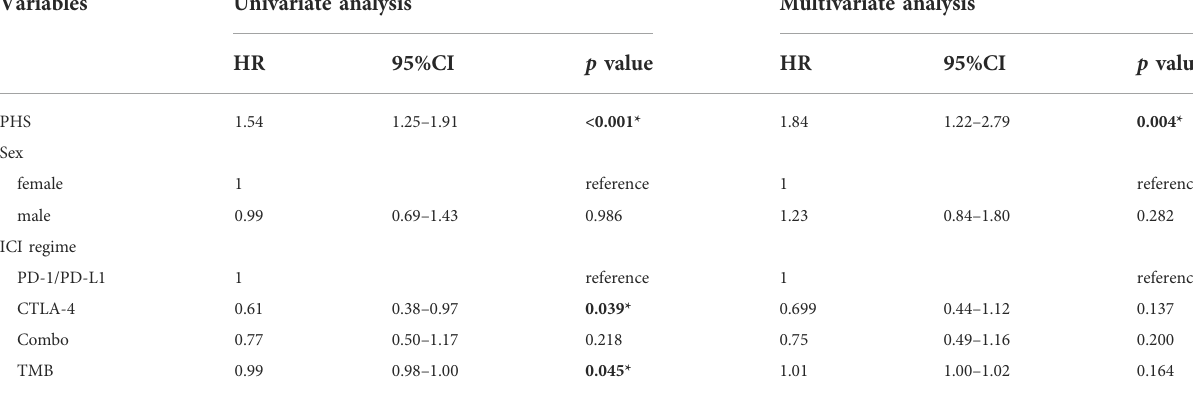
TABLE 3 Univariate and multivariate analyses of PHS associated with overall survival in the MSK-IMPACT metastatic melanoma cohort that underwent ICI treatment.